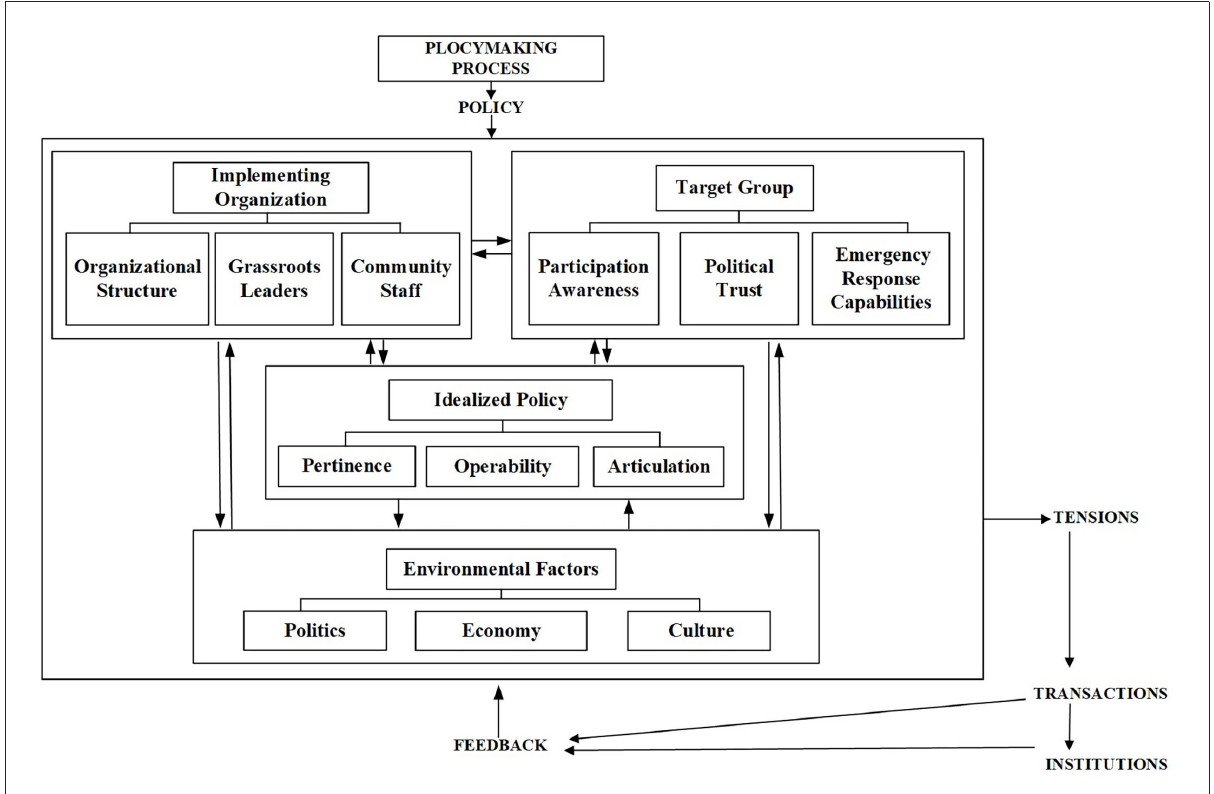
FIGURE2 Analysis framework based on the Smith Policy-Implementation-Processing